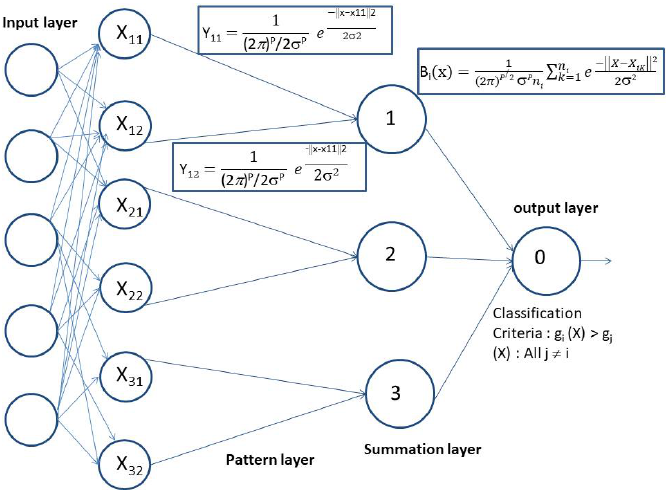
Figure 3. Architecture of probabilistic neural